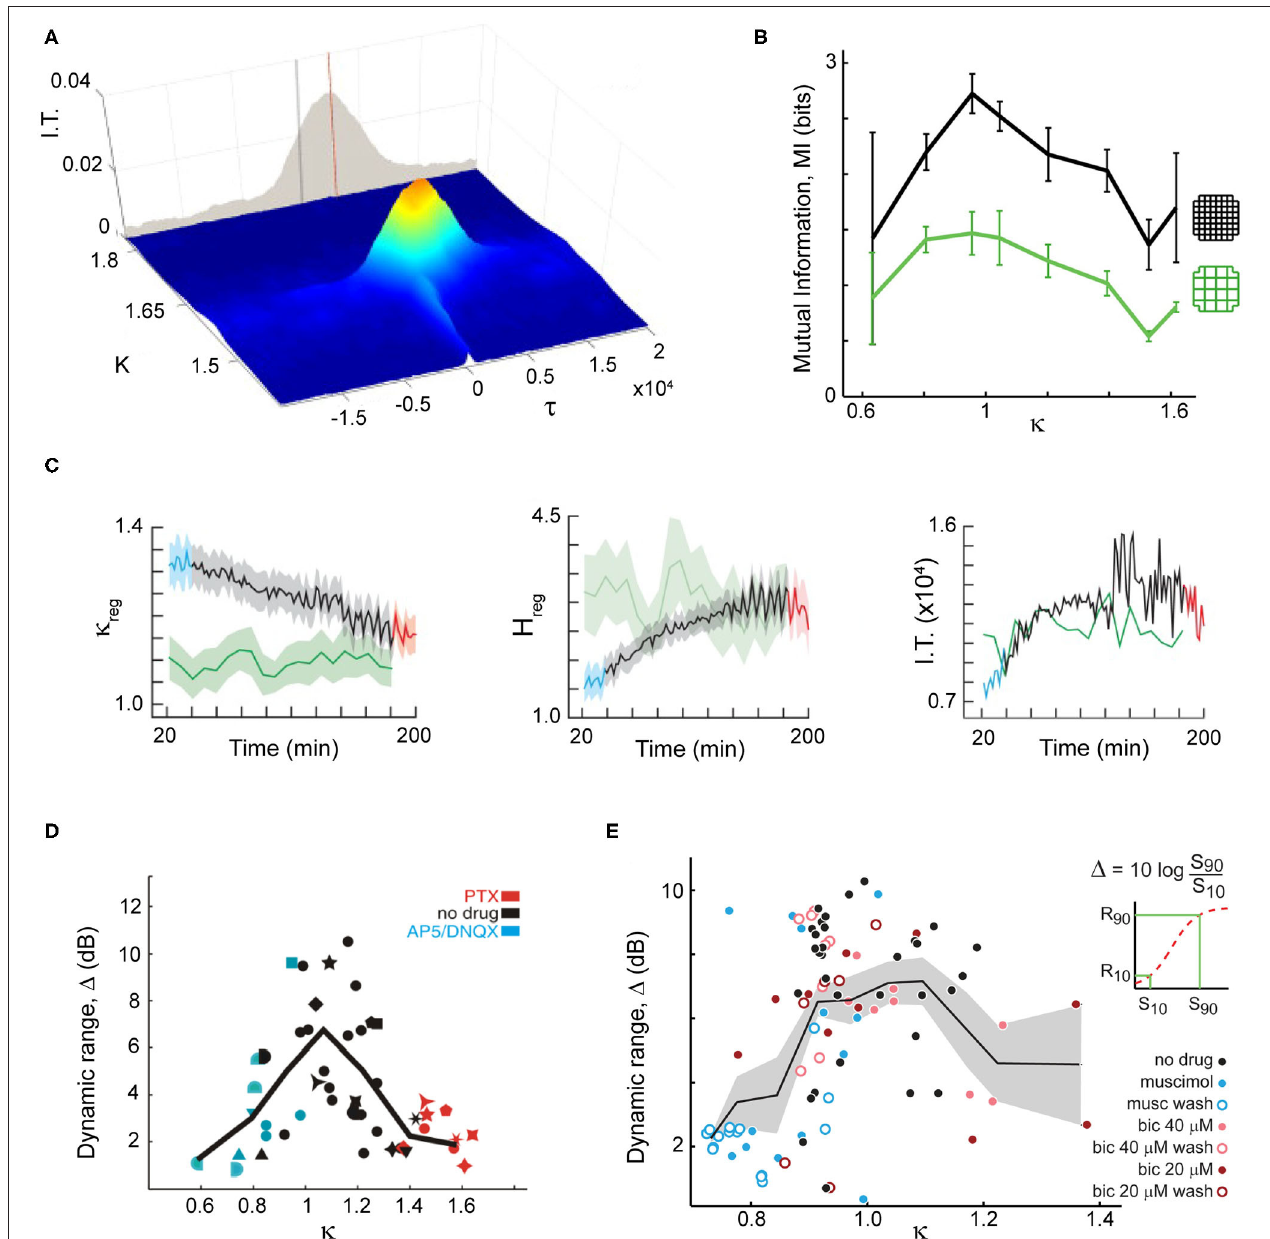
FIGURE 2 | Criticality and scale-free organization provide key advantages for both flocks and brains such as maximal information transmission and dynamic range. (A) In a decision-making model of flock behavior, information transmission peaks at criticality, shown by a peak in mutual information for K ∼ 1.62 and τ ∼ 2,500 (critical point). Adapted from Lukovic et al. (2014). (B) In organotypic cultures grown from rodent brains, information transmission peaks when spontaneous neuronal activity displays scale-free neuronal avalanches, in line with expectation from criticality ( κ ∼ 1). Two different coarse-graining levels are shown ( colors ). Proximity to criticality, i.e., scale-free avalanches, is controlled through pharmacological manipulation of the cultures. Adapted from Shew et al. (2011). (C) Information transmission is maximized as mice recover from anesthesia, establishing neuronal avalanches. Left : Criticality distance measure approaches 1 (critical point) as time from anesthesia application (in min) passes. Anesthetized ( blue ), recently awake ( red ) and fully awake ( green ) states are highlighted. Entropy ( middle ) and information transmission ( right ) reaches a maximum as mice recover from anesthesia and reestablishing neuronal avalanches. Adapted from Fagerholm et al. (2016). (D) In organotypic cortex cultures, the dynamic range peaks when neuronal avalanches emerge and can be reduced when pharmacologically changing the natural excitation/inhibition balance. Adapted from Shew et al. (2009). (E) Using microelectrode array recordings in rats in vivo , the peak of dynamic range was demonstrated using natural stimuli and changes in excitation/inhibition balance through local pharmacological manipulation. Adapted from Gautam et al. (2015).